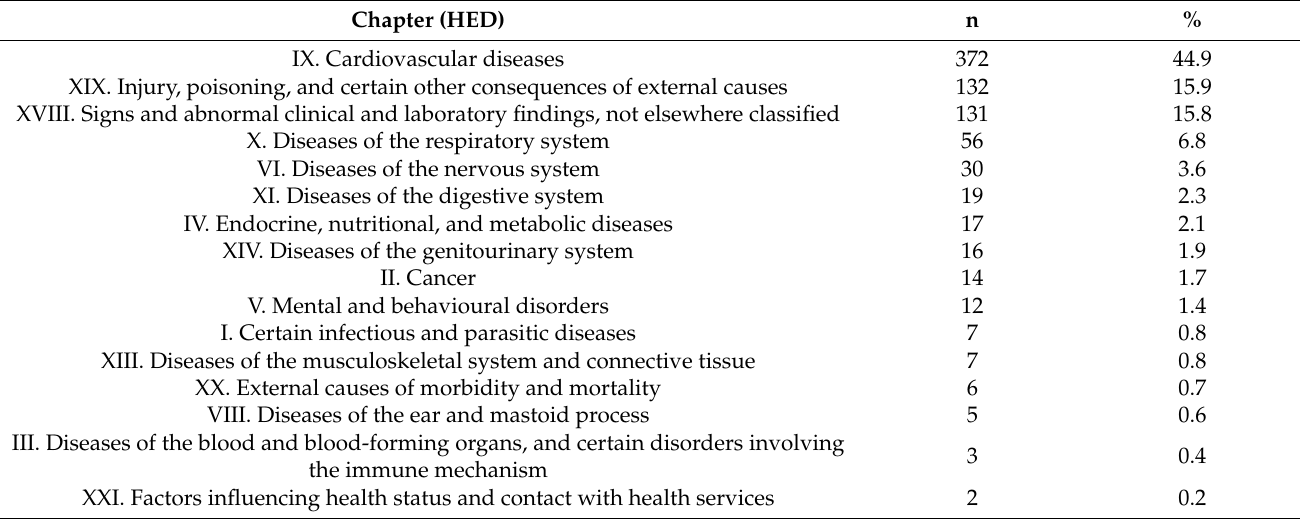
Table 4. The most common diagnoses made by an HED doctor on